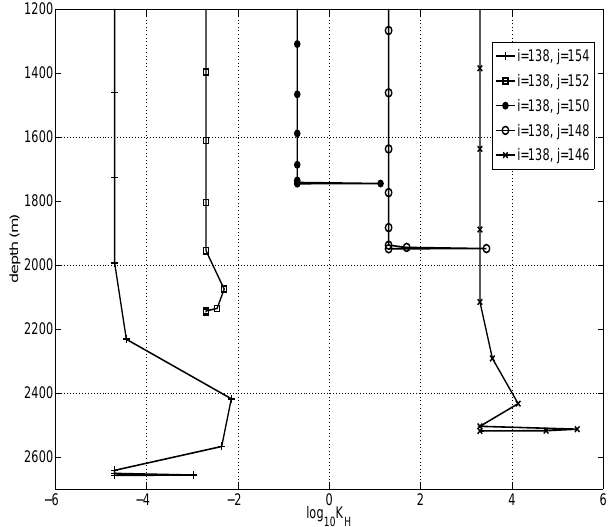
Fig. 14. Profiles of the coefficient of vertical diffusion of tempera- ture and salinity, K H (m 2 s − 1 ). Profiles are offset as in Fig. Fig.14. Profilesofthecoefficientofverticaldiffusionoftemperatureorsalinity, K H [ m 2 /s ] . Profilesareoffset asinFig.8.